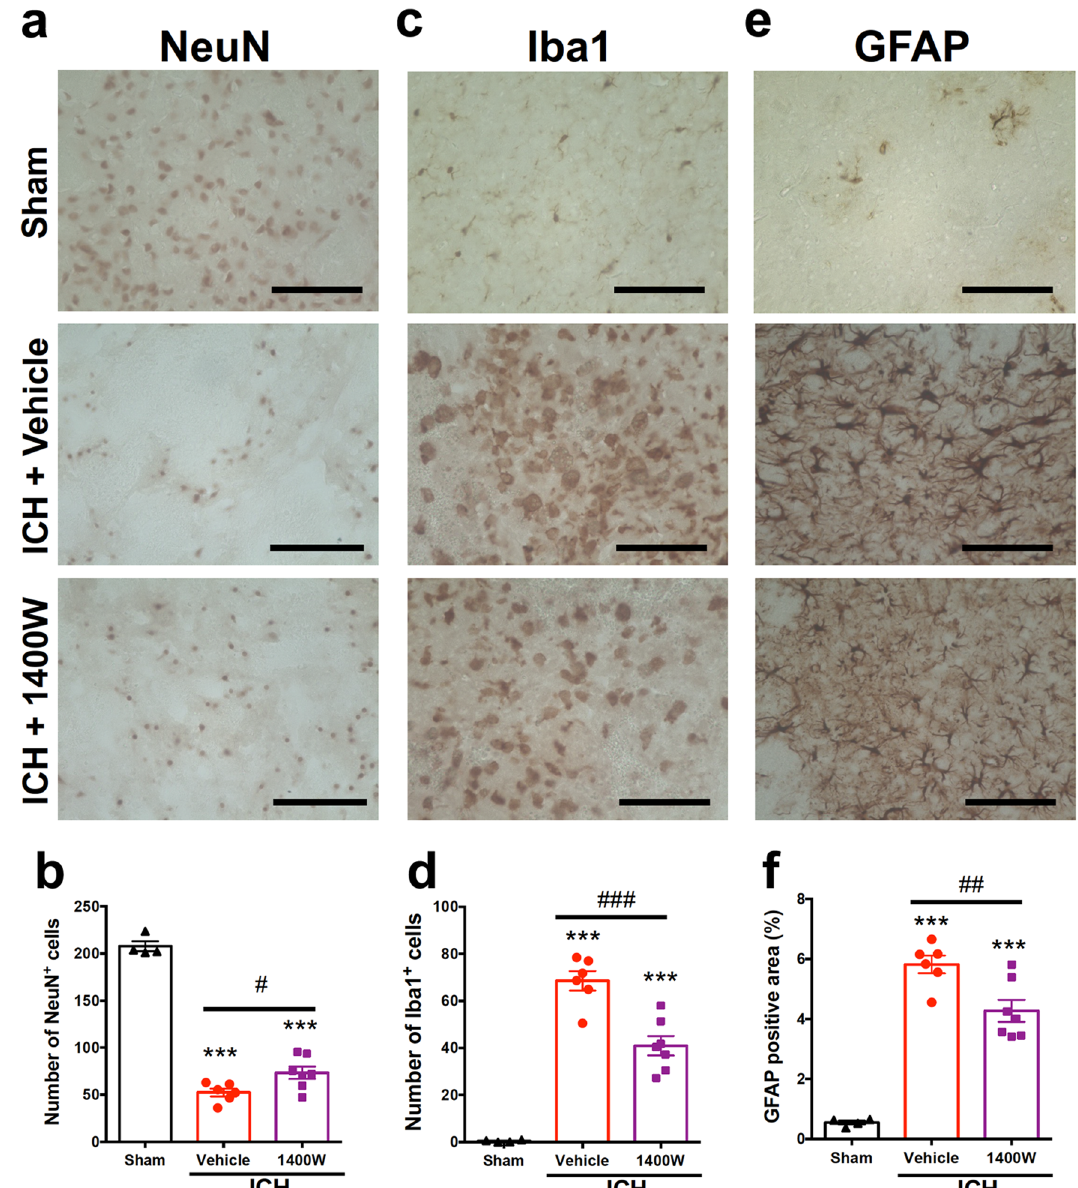
Figure 7. Effect of iNOS inhibitor on ICH-induced neural death, activation of microglia/macrophages and accumulation of astrocytes. 1400 W (20 mg/kg) or vehicle was intraperitoneally administered twice daily for six times, from 3 h after ICH induction. Immunohistochemical examinations for NeuN, Iba1 and GFAP were conducted on coronal brain sections obtained at 72 h after ICH. ( a ) Representative images of NeuN immunohistochemistry. Magnified views of the regions for quantification obtained from a mouse of sham group, ICH + vehicle group and ICH + 1400 W group are shown. Scale bars = 100 μm. ( b ) Quantitative results of NeuN-positive cells in the central region of hematoma. ( c ) Representative images of Iba1 immunohistochemistry. Scale bars = 100 μm. ( d ) Quantitative results of Iba1-positive cells in the peri-hematoma region. ( e ) Representative images of GFAP immunohistochemistry. Scale bars = 100 μm. ( f ) Quantitative results of GFAP-positive area in the peri-hematoma region. Number of mice examined was 4 in sham group, 6 in ICH + vehicle group and 7 in ICH + 1400 W group, respectively. *** P < 0.001 versus sham group, # P < 0.05, ## P < 0.01, ### P < 0.001 (ANOVA results: for b , F 2,14 = 172.3, P < 0.001; for d , F 2,14 = 63.29, P < 0.001; for f , F 2,14 = 57.42, P <